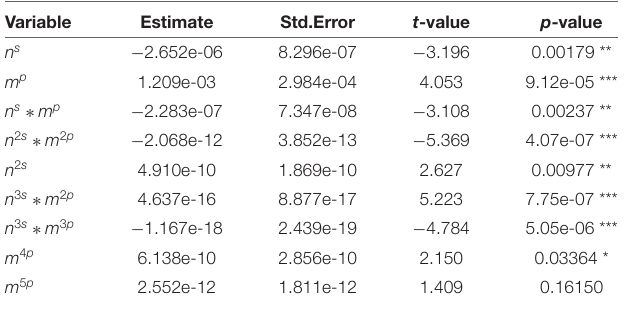
TABLE 3 | Summary statistics for selected variables in finite sample size between 51 and 70.